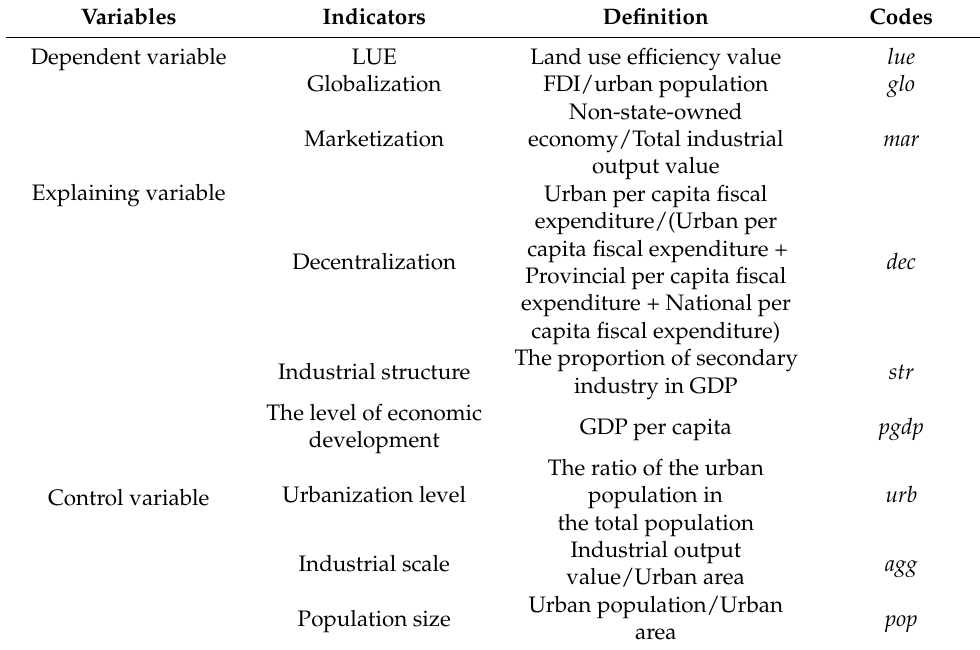
Table 2. Explanation of LUE and impact